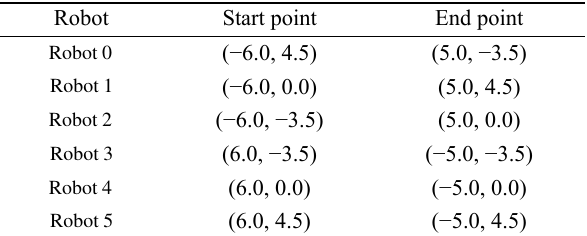
Table 3 Coordinates of the start and end points of each robot.